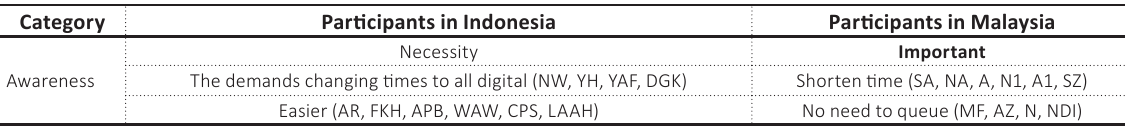
Table 3. Awareness of using